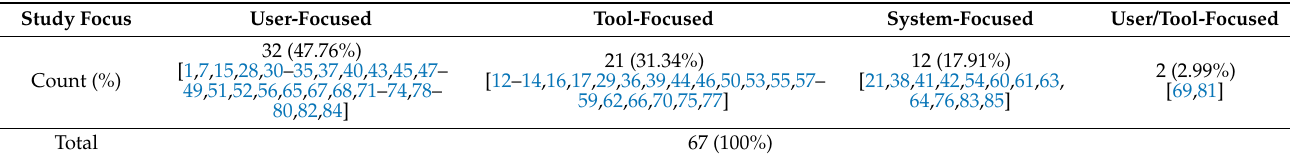
Table 3. Summary of study